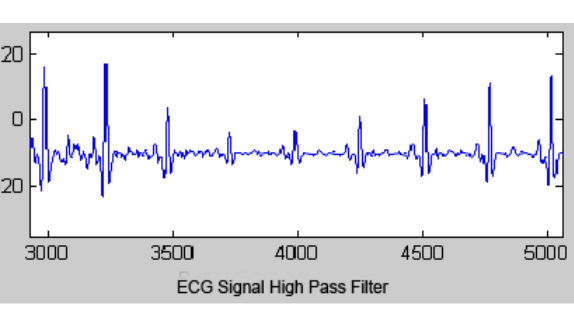
Figure 4. High pass filtered